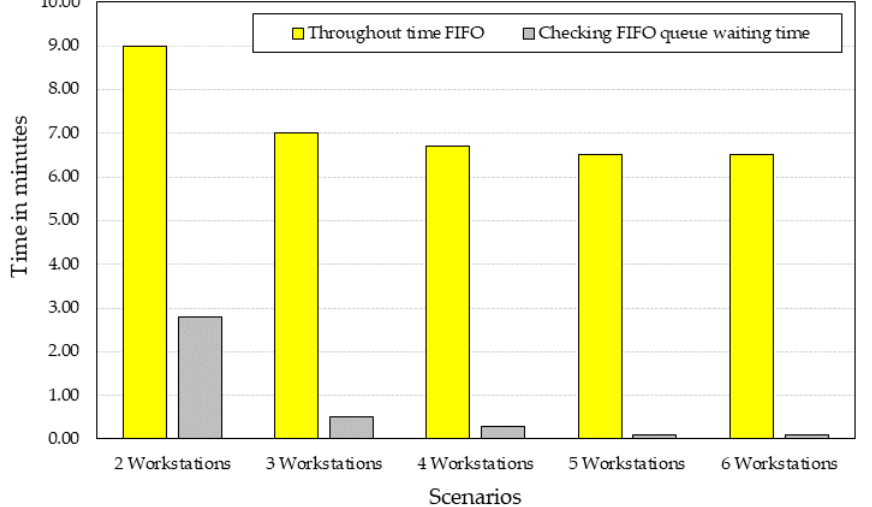
Figure 11. Comparison chart of several scenarios.